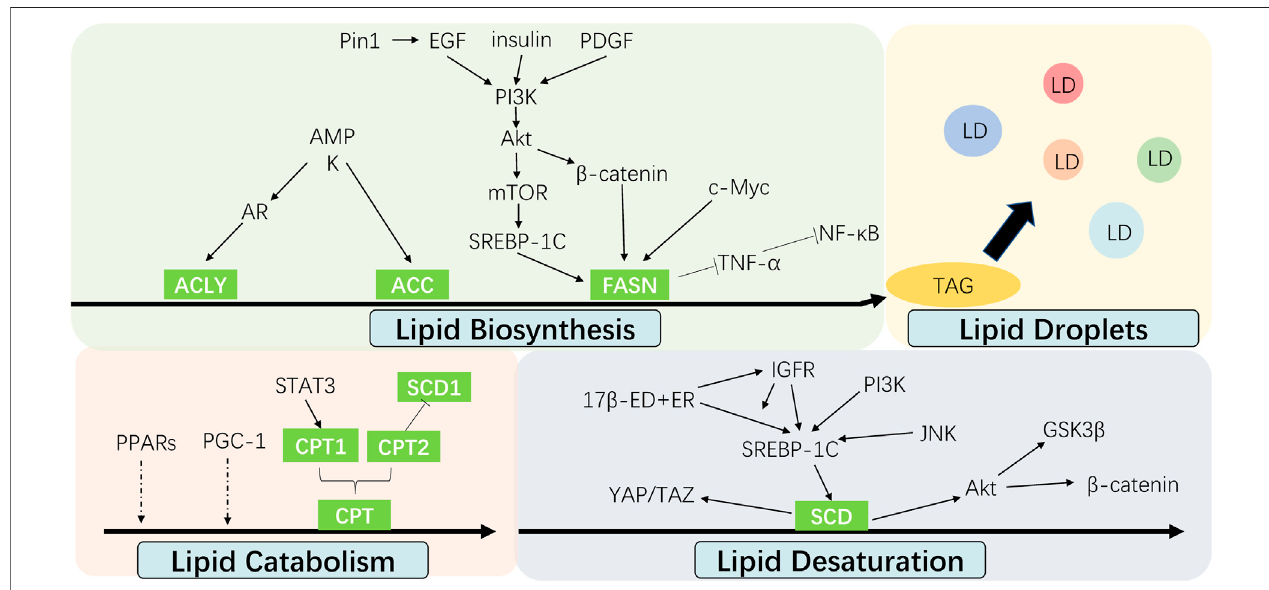
FIGURE 3 | Interaction between cell signalings and altered fatty acid metabolism in cancer chemoresistance. The alteration of fatty acid metabolism including lipid biosynthesis, lipid desaturation, lipid droplets formation and lipid catabolism contributes to cancer chemoresistance, which are regulated by multiple signal molecules.